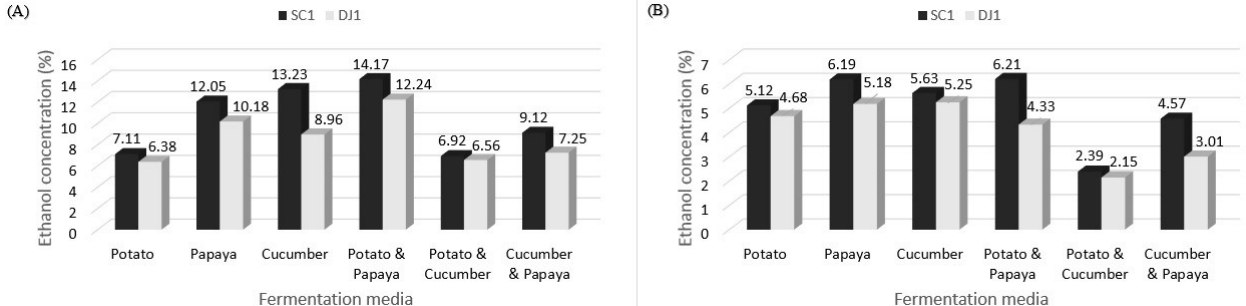
Figure 3. Alcohol production from vegetable peels by yeast isolates SC1 and DJ1 at pH 6. Media treated with Bacillus subtilis ( A ) and No pre-treatment ( B ).